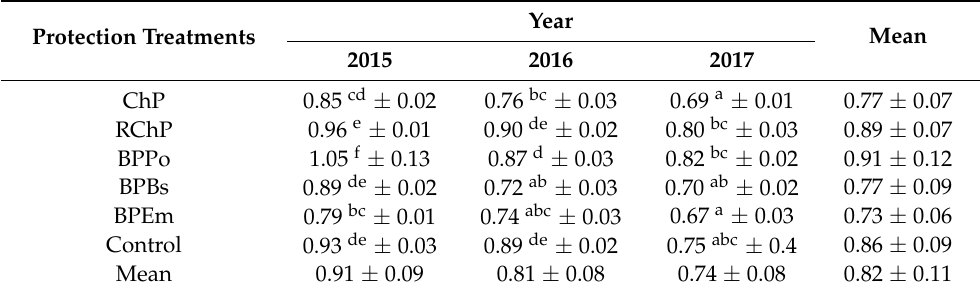
Table 9. Effect of protection treatments and the year of horseradish cultivation on fat content (g · 100 g − 1 dry